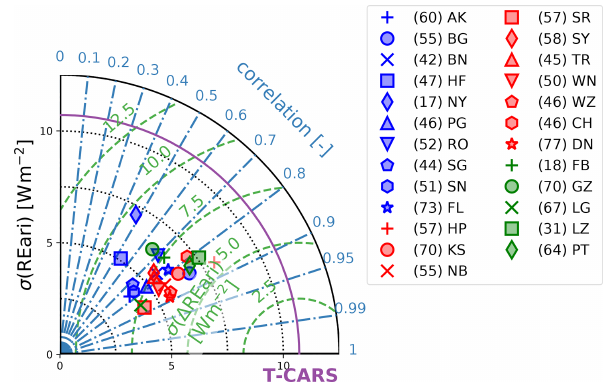
Figure 10. The REari simulated at different DWD observation sta- tions as the average over all CSM is compared to the collocated T– CARS simulation. The annual variability is indicated by the stan- dard deviation ( σ ) of the individual dataset. The performance of REari calculated at a station is displayed by the SD of the REari dif- ference and correlation versus T–CARS. The amount of days with a successful clear-sky fit are displayed in brackets in front of the sta- tion name in the legend. Station markers are colour coded based on their location labels (see Table 1): northern stations (blue), southern stations (red) and remaining stations